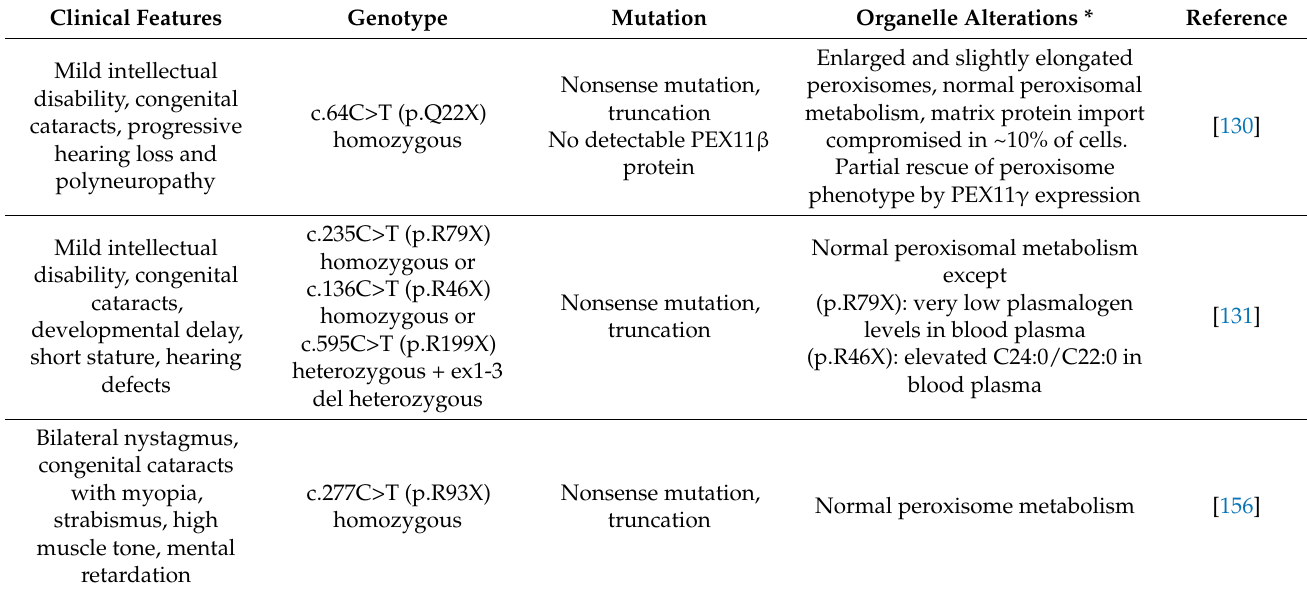
Table A3. Gene—PEX11 β ; Protein—Peroxin 11 β ; Function—regulator of peroxisome elongation and division. * Data from patient-derived cells or plasma unless otherwise stated.